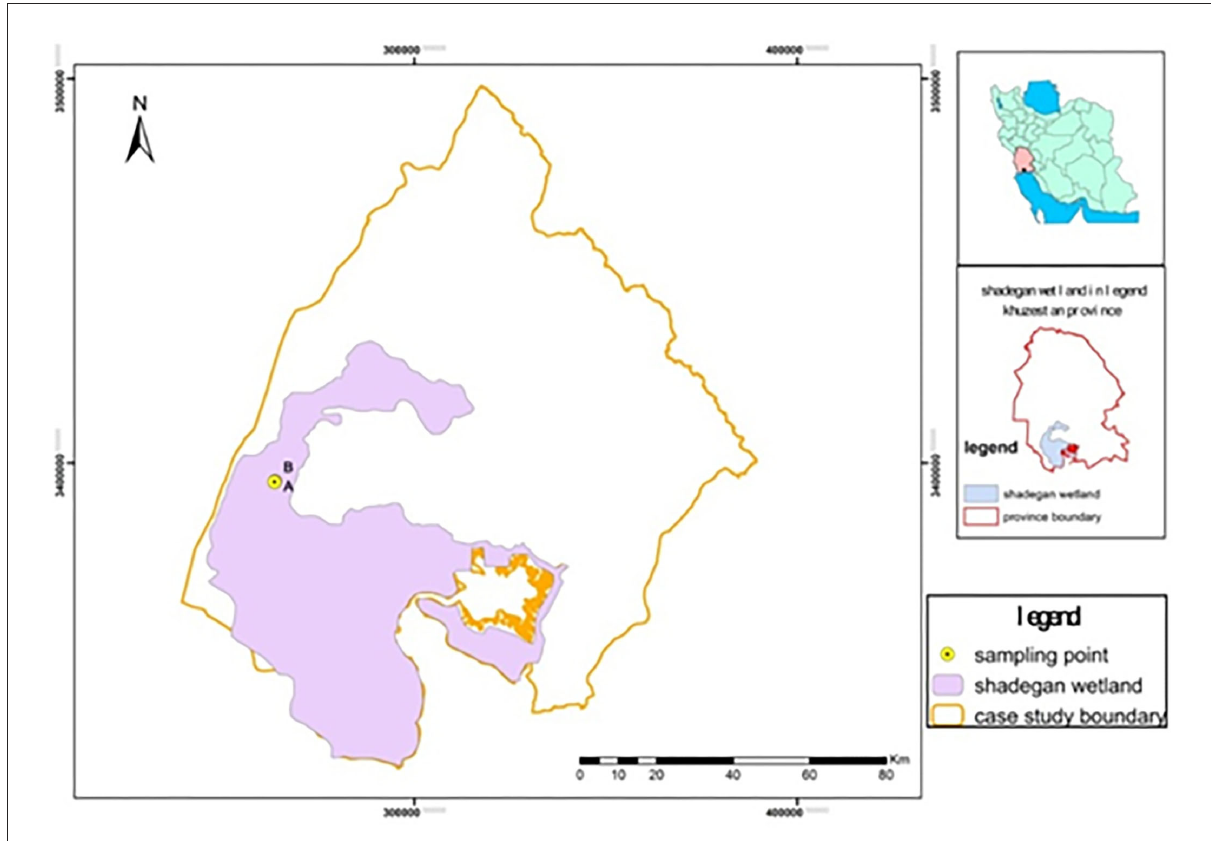
FIGURE1 The geographical location of Shadegan coastal water and soil sampling